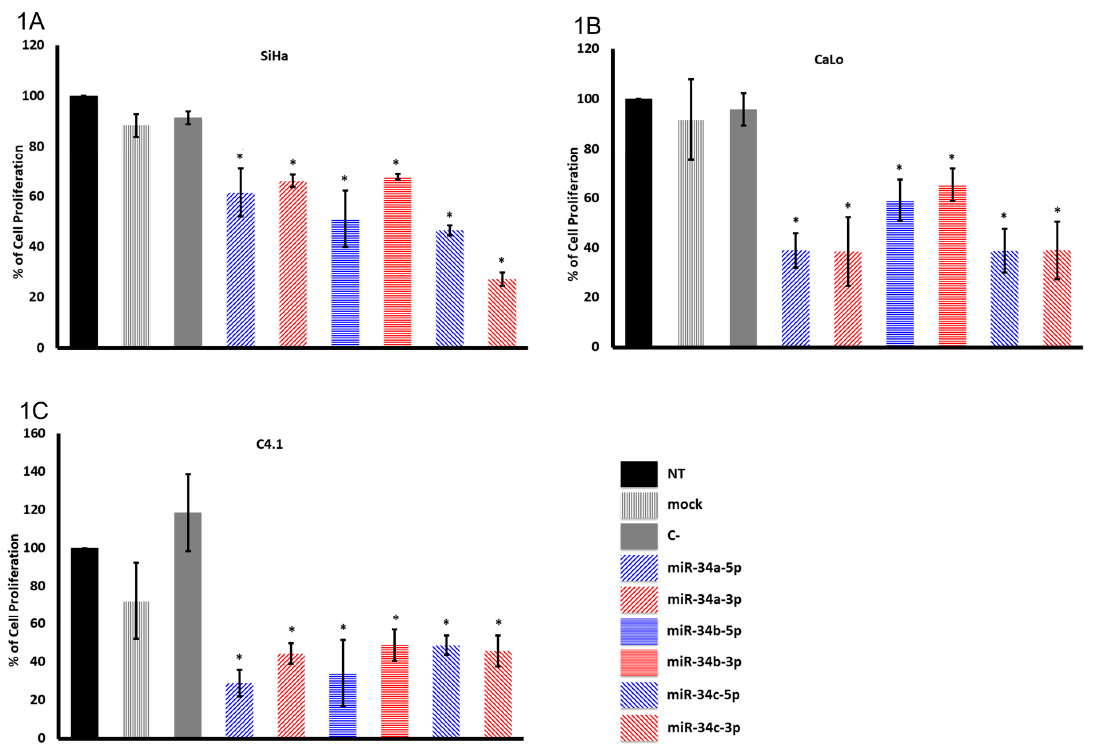
Figure 1. Ectopic expression of microRNA 34 (miR-34) family members inhibits proliferation in SiHa, CaLo, and C4.1 cells. ( A ) The human papillomavirus (HPV)-16-positive tumor cell line SiHa; ( B ) the HPV-18-positive tumor cell line CaLo; ( C ) the HPV-18-positive tumor cell line C4.1. The cell lines were transfected with 10 nM pre-miR-34a-5p, pre-miR-34a-3p, pre-miR-34b-5p, pre-miR-34b3p, pre-miR-34c-5p, and pre-miR-34c-3p mimics, or scrambled pre-miRNA control (C-) to evaluate cell proliferation with crystal violet 72 h post-transfection. Non-treated (NT) and mock-transfected (mock) cells were used as positive proliferation controls. The bars represent means and standard deviations of three independent experiments in triplicate (p < 0.05).